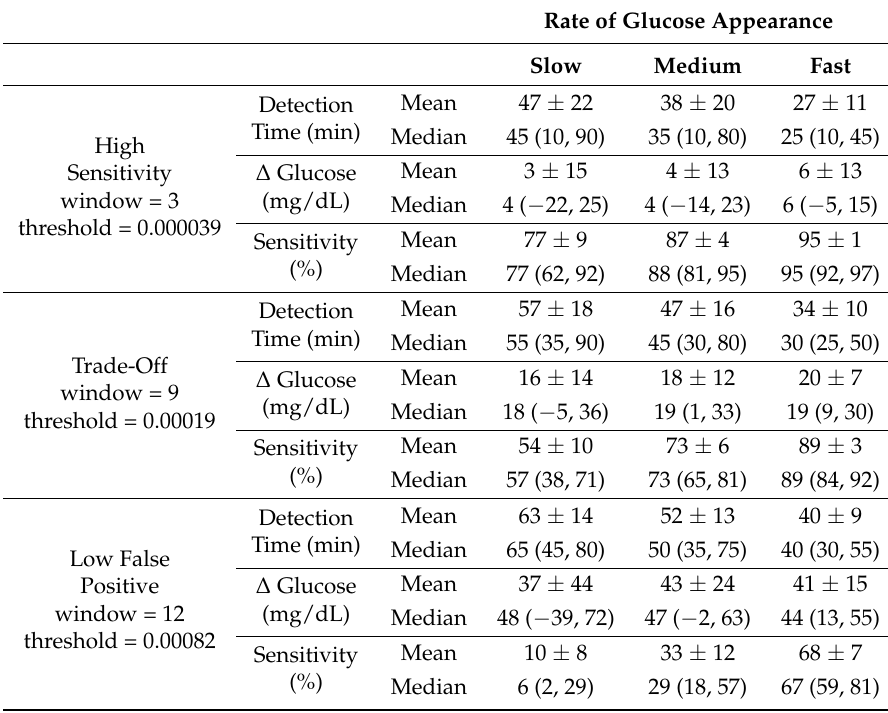
Table 5. Analysis of the effect of rate of glucose appearance on detection time, ∆ glucose, and sensitivity.